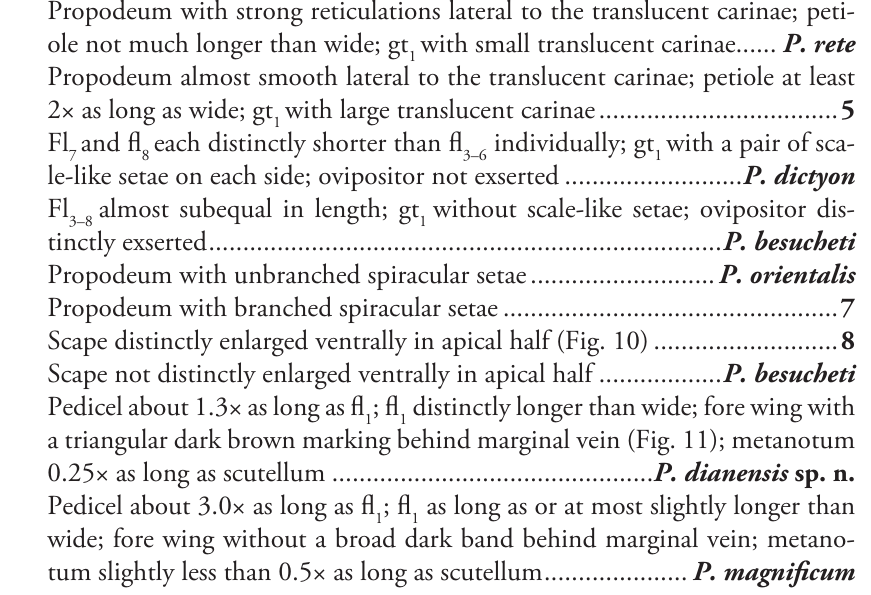
; fl distinctly longer than wide; fore wing with 1 1 ; fl as long as or at most slightly longer 1 1